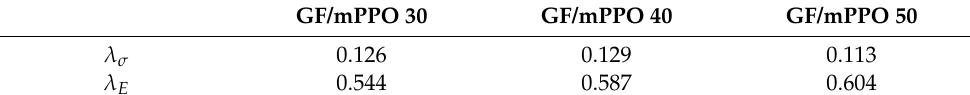
Table 3. The fiber efficiency factor for tensile strength and modulus of GF/mPPO composites.